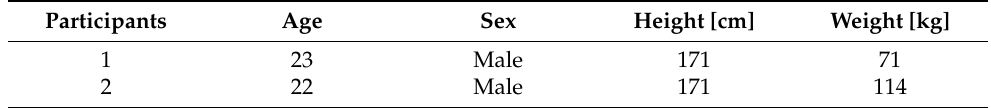
Table 2. Details of study participants.